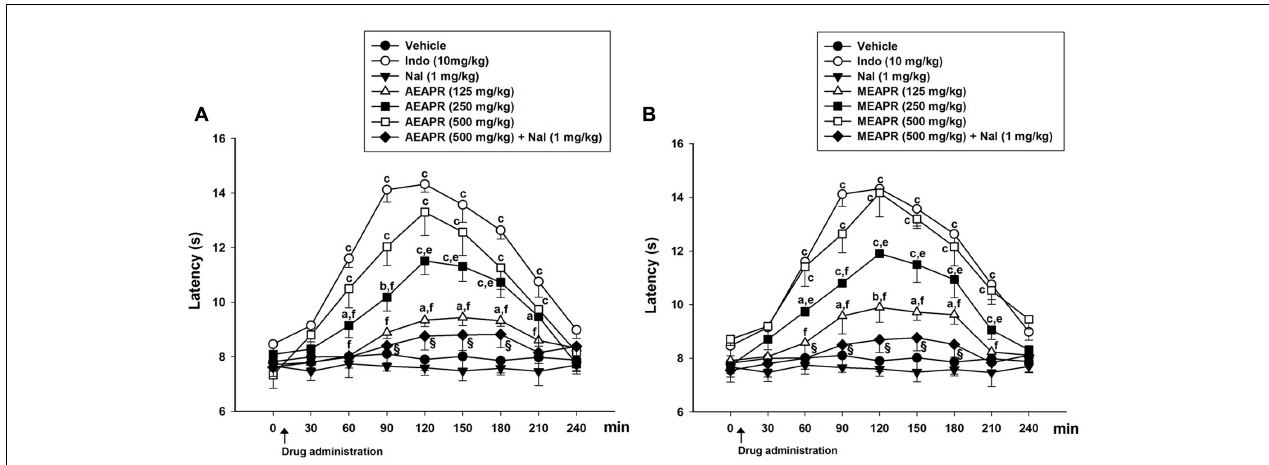
FIGURE 6 | Effect of single administration of AEAPR (A) and MEAPR (B) in the hot plate test. Animals (six mice each group) were treated orally with vehicle (distilled water), indomethacin (Indo), MEAPR or AEAPR (125, 250, 500 mg/kg or 500 mg/kg + naloxone (1 mg/kg) (Nal), prior to 55 ◦ C thermal tests. Naloxone was administered alone or 30 min before administration of AEAPR and MEAPR. Each point represents the mean ± SEM of the response latency (in seconds) at different time points after the drug administration. a p < 0.05, b p < 0.01, and c p < 0.001 in comparison with the vehicle-treated group; d p < 0.05, e p < 0.01, and f p < 0.001 in comparison with the indomethacin-treated group, using Holm–Sidak post hoc